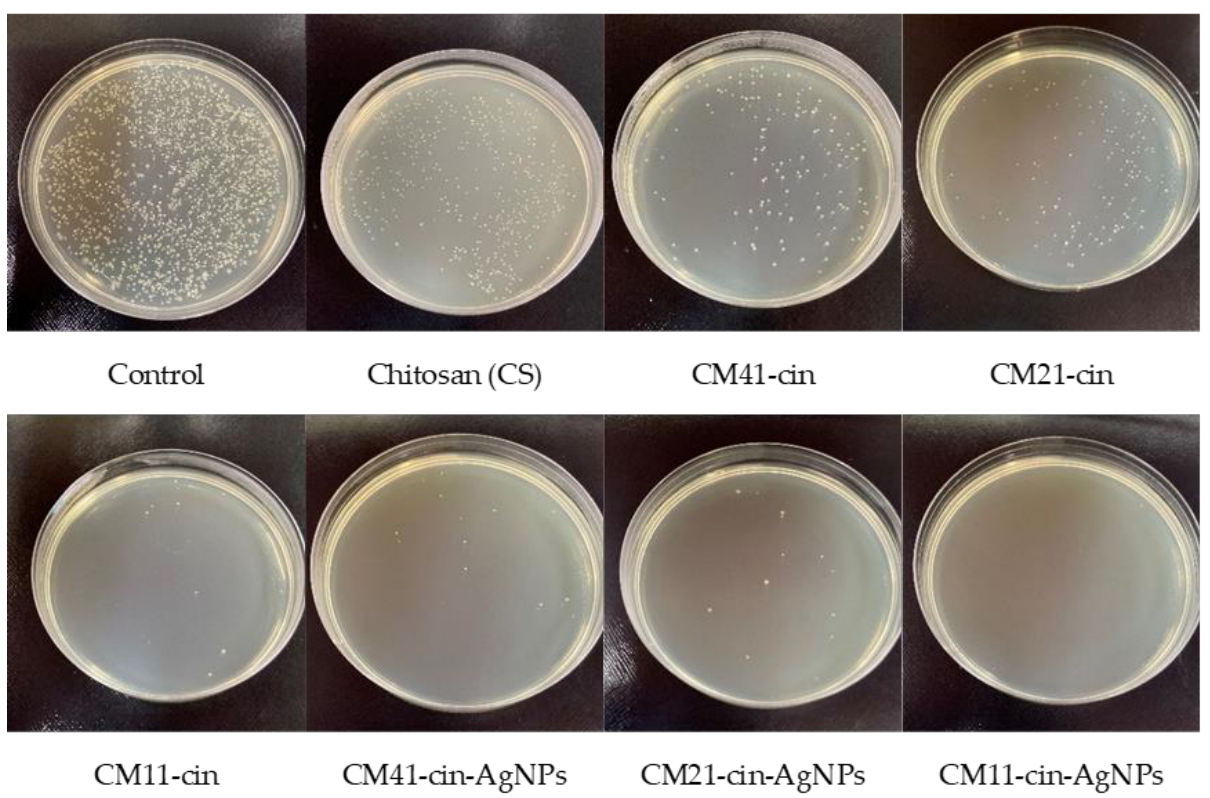
Figure 6. The representative agar plate image of viable S. aureus counts after 6 h of contact with different hydrogels.